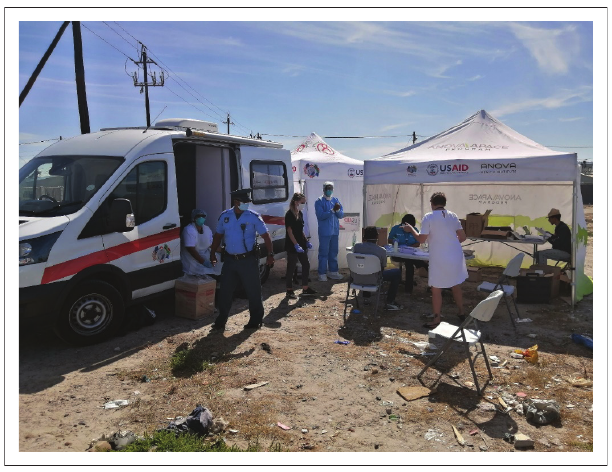
FIGURE 1: Family doctors assist with community screening and testing in Cape